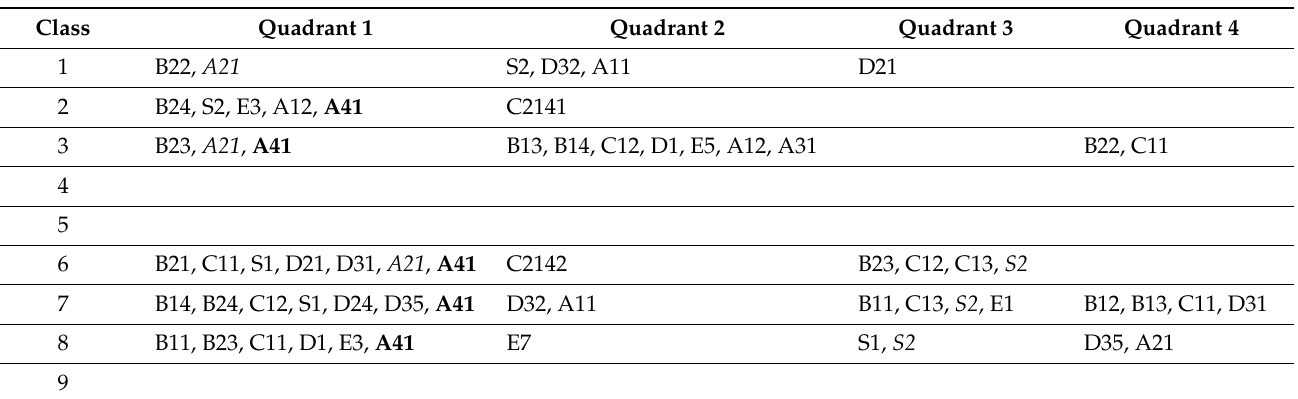
Table 12. Multiple cases: differentiating between personal and other people’s emotions (A51) as a focal B = behavior with category selection as conditioned